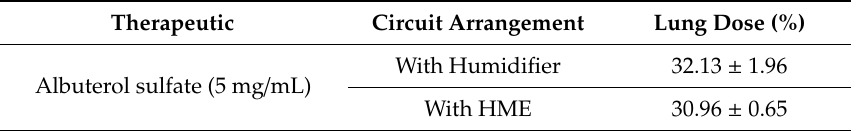
Table 2. E ff ect of ventilator circuit configuration on the e ffi cacy of aerosol